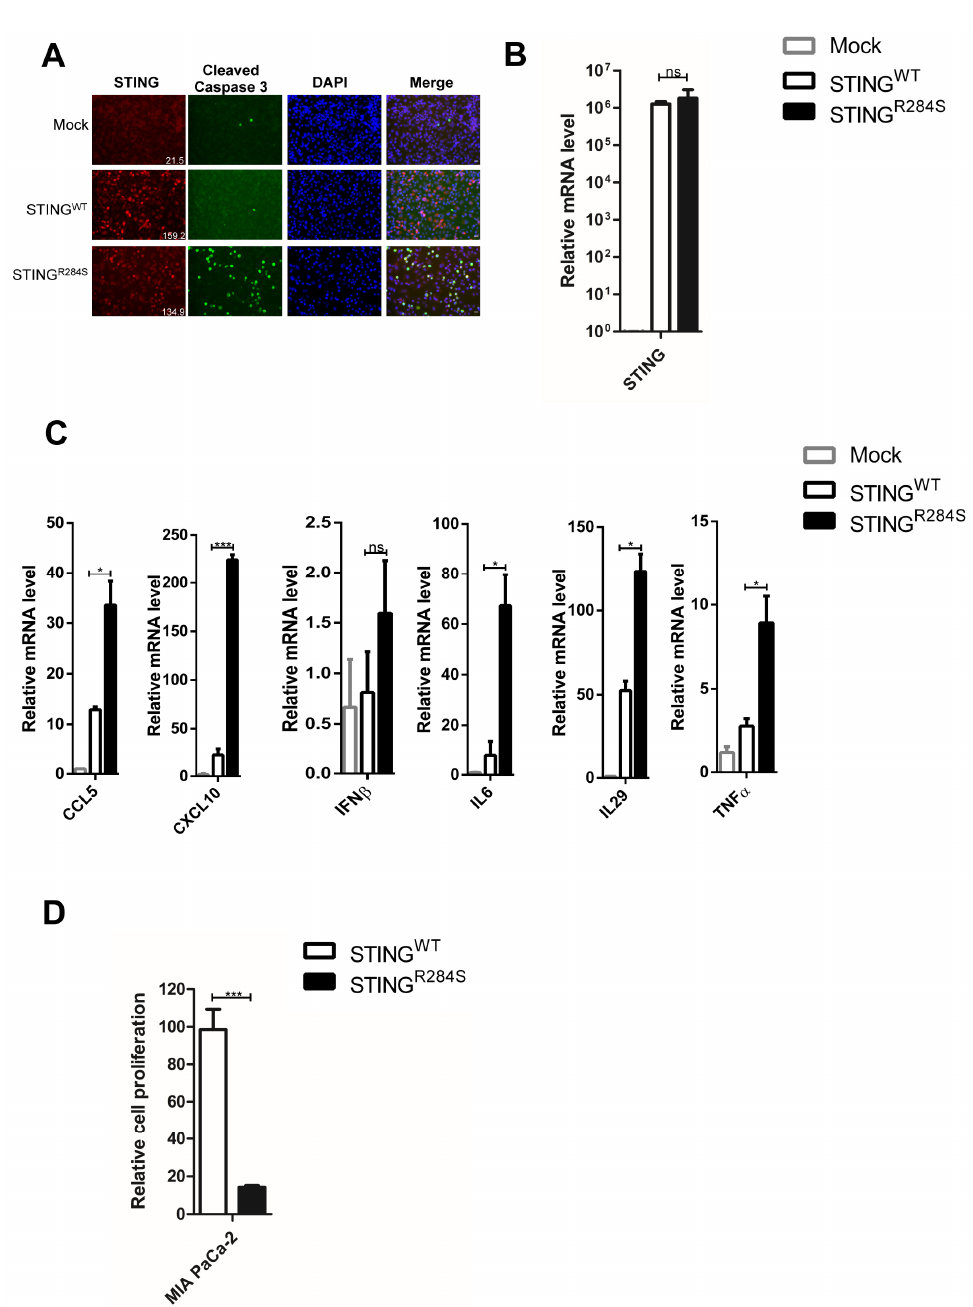
Figure 4. Transfection of STING R284S mRNA activates vital antitumor cytokine production and triggers PDAC cell death. ( A – C ) 10e 4 MIA PaCa-2 cells were transfected with 0.5 µ g STING WT or STING R284S mRNA. Untreated MIA PaCa-2 cells were used as a negative control (mock). At 15 h post-transfection, cells were stained for STING (Red) and Cleaved Caspase-3 (Green) Scale bar: 20 µm. ( A ), STING WT and STING R284S expression were confirmed by RT-qPCR ( B ), and the mRNA levels of the indicated genes were measured by RT-qPCR and normalized to the GAPDH mRNA level ( C ). In ( A ), the mean fluorescence intensity of the STING images was quantified using ImageJ software and denoted at the bottom right corner. The values for untreated cells (Mock) were set to 1. ( D ) 0.5 × 10e 4 MIA PaCa-2 cells were transfected with 1 µ g STING WT or STING R284S mRNA. At 15 h post-transfection, cell viability was measured by the CellTiter-GLO 3D cell viability assay. Error bars represent the SEM of three independent experiments. (ns: not significant, * p < 0.05, *** p < 0.001).